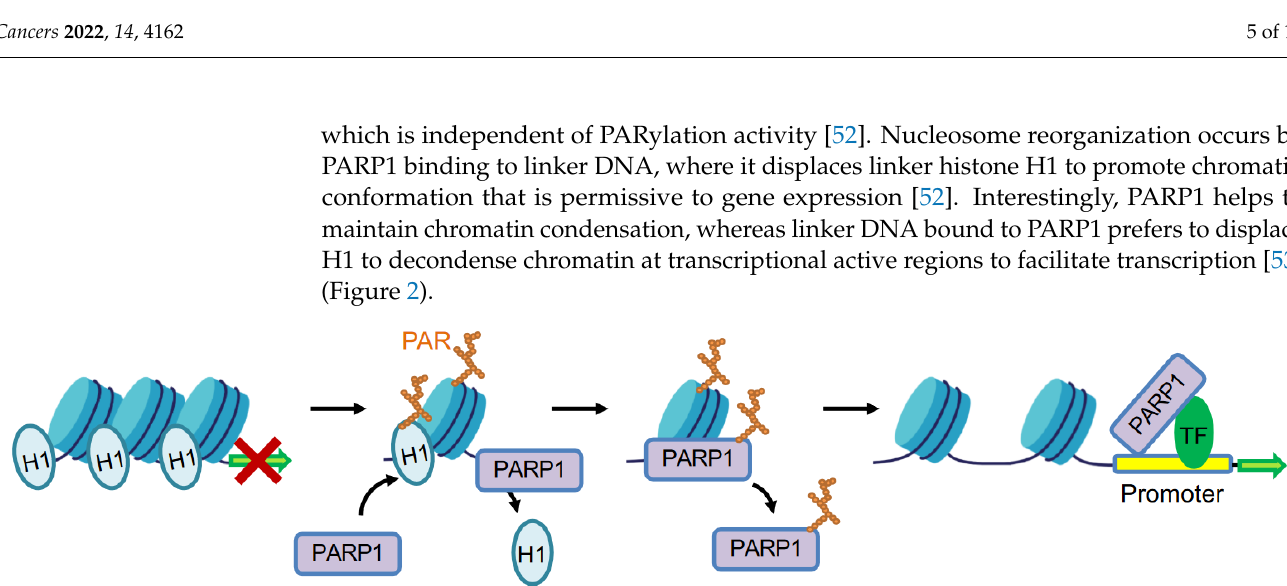
Figure 2. PARP1 regulates transcription by facilitating local chromatin decondensation at active gene sites. Activated PARP1 mediates H1 PARylation and displacement from chromatin to form euchromatin environment. PARP1 also physically interacts with transcription factors (TF), with or without its enzymatic activity, to modulate gene transcription.